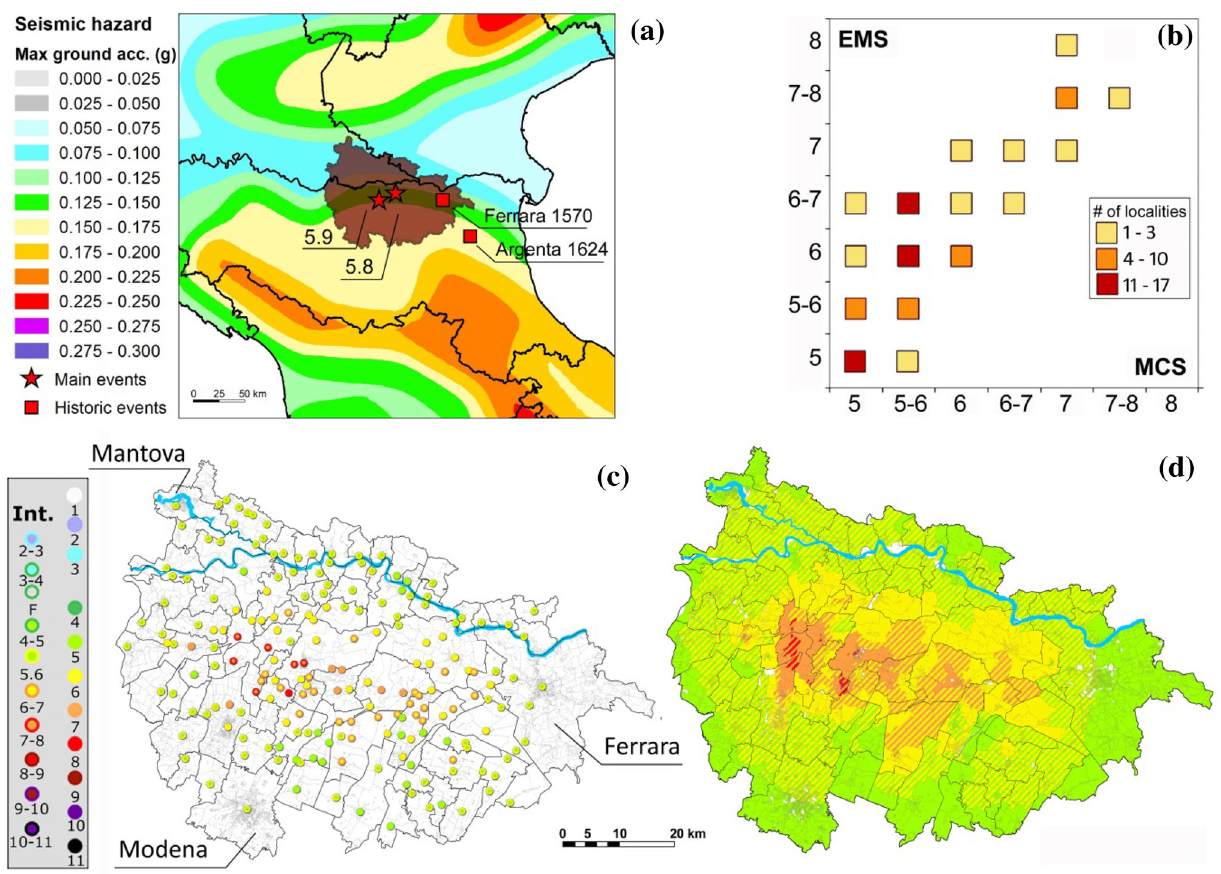
Fig. 1 Investigated area and related seismic data. a The seismic hazard map of northern Italy with regions (black boundaries) and the study area (brown shape). b Comparison between EMS-98 and MCS (Mercalli Cancani Sieberg) macroseismic observations; results are represented in three classes according to the number of the surveyed